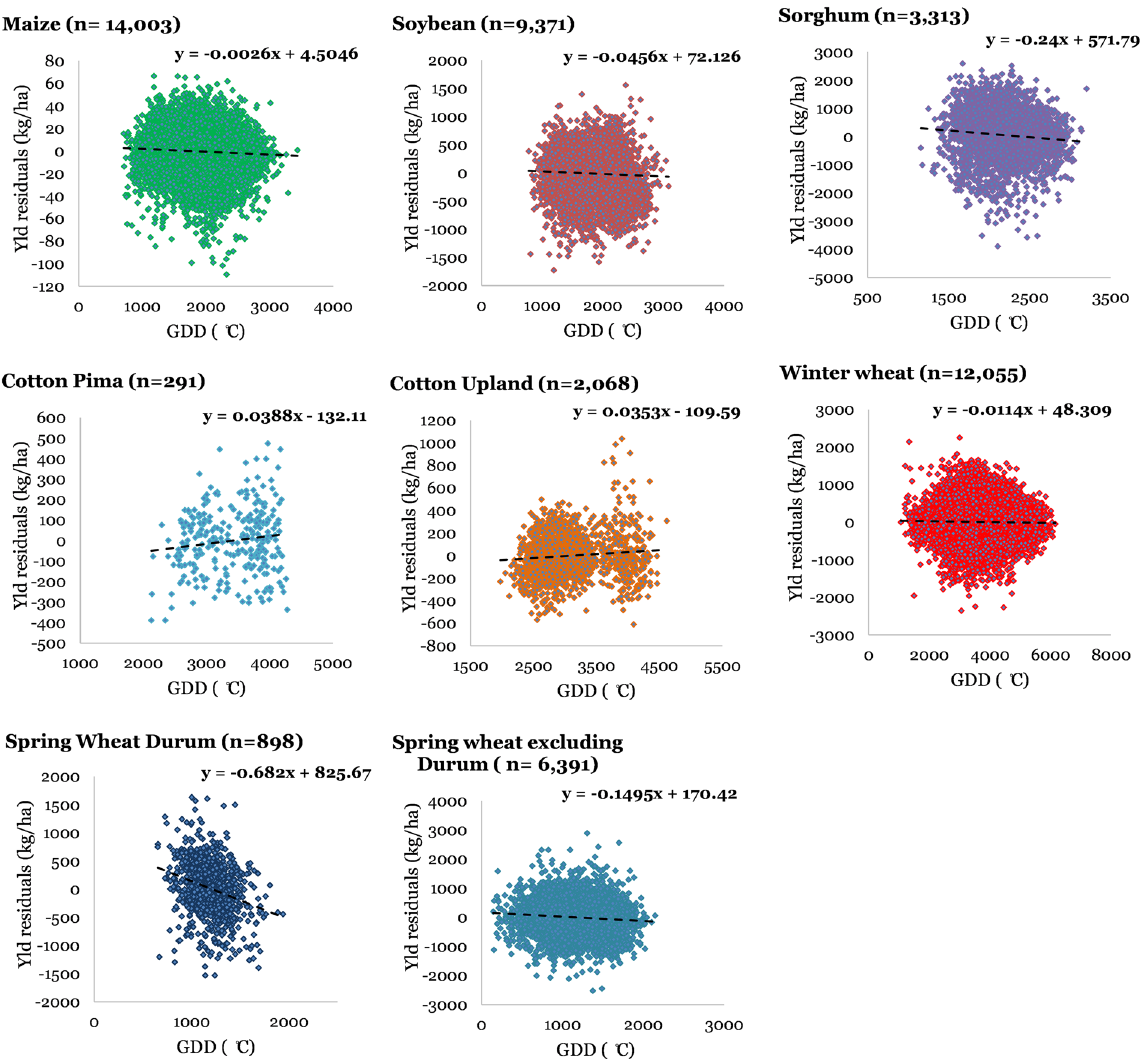
Figure 8. County-level relationships among yield and growing degree days (GDD) pooled nationally for maize, soybean, sorghum, cotton (pima and upland), winter wheat, and spring wheat (durum and non-durum). Each regression curve includes n number of site-years in the CONUS during